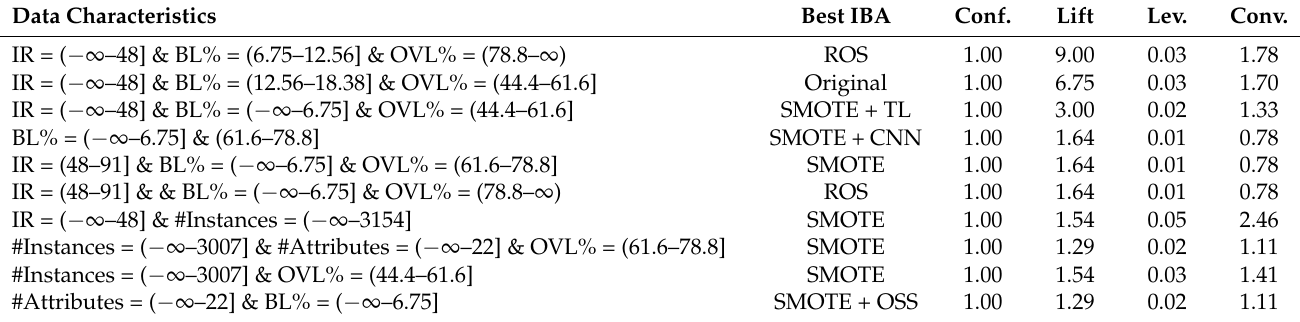
Table 2. Evaluation of the best method regarding IBA values by means of association rules. Data Characteristics